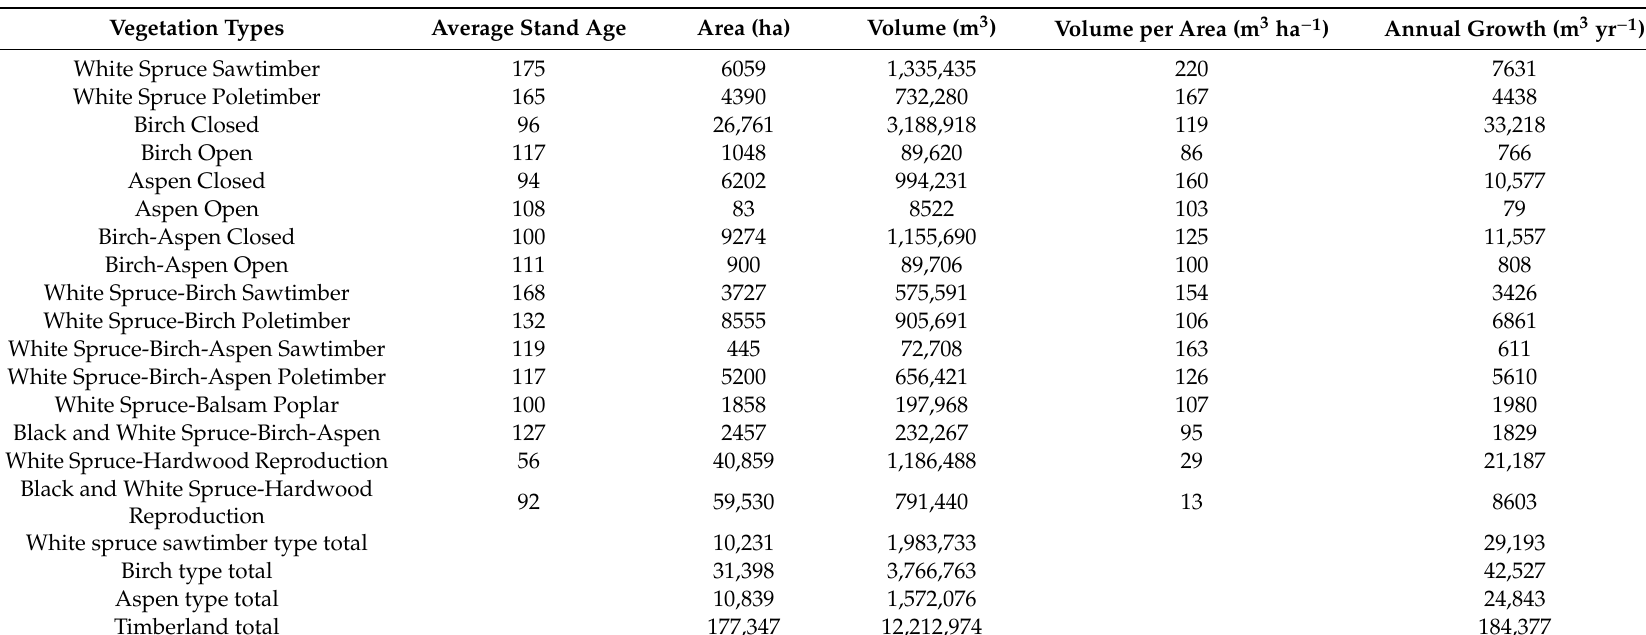
Table 3. Average stand age, area, timber volume, volume per area, average annual growth, and annual growth of each timberland vegetation type on state forest lands (Kantishna management